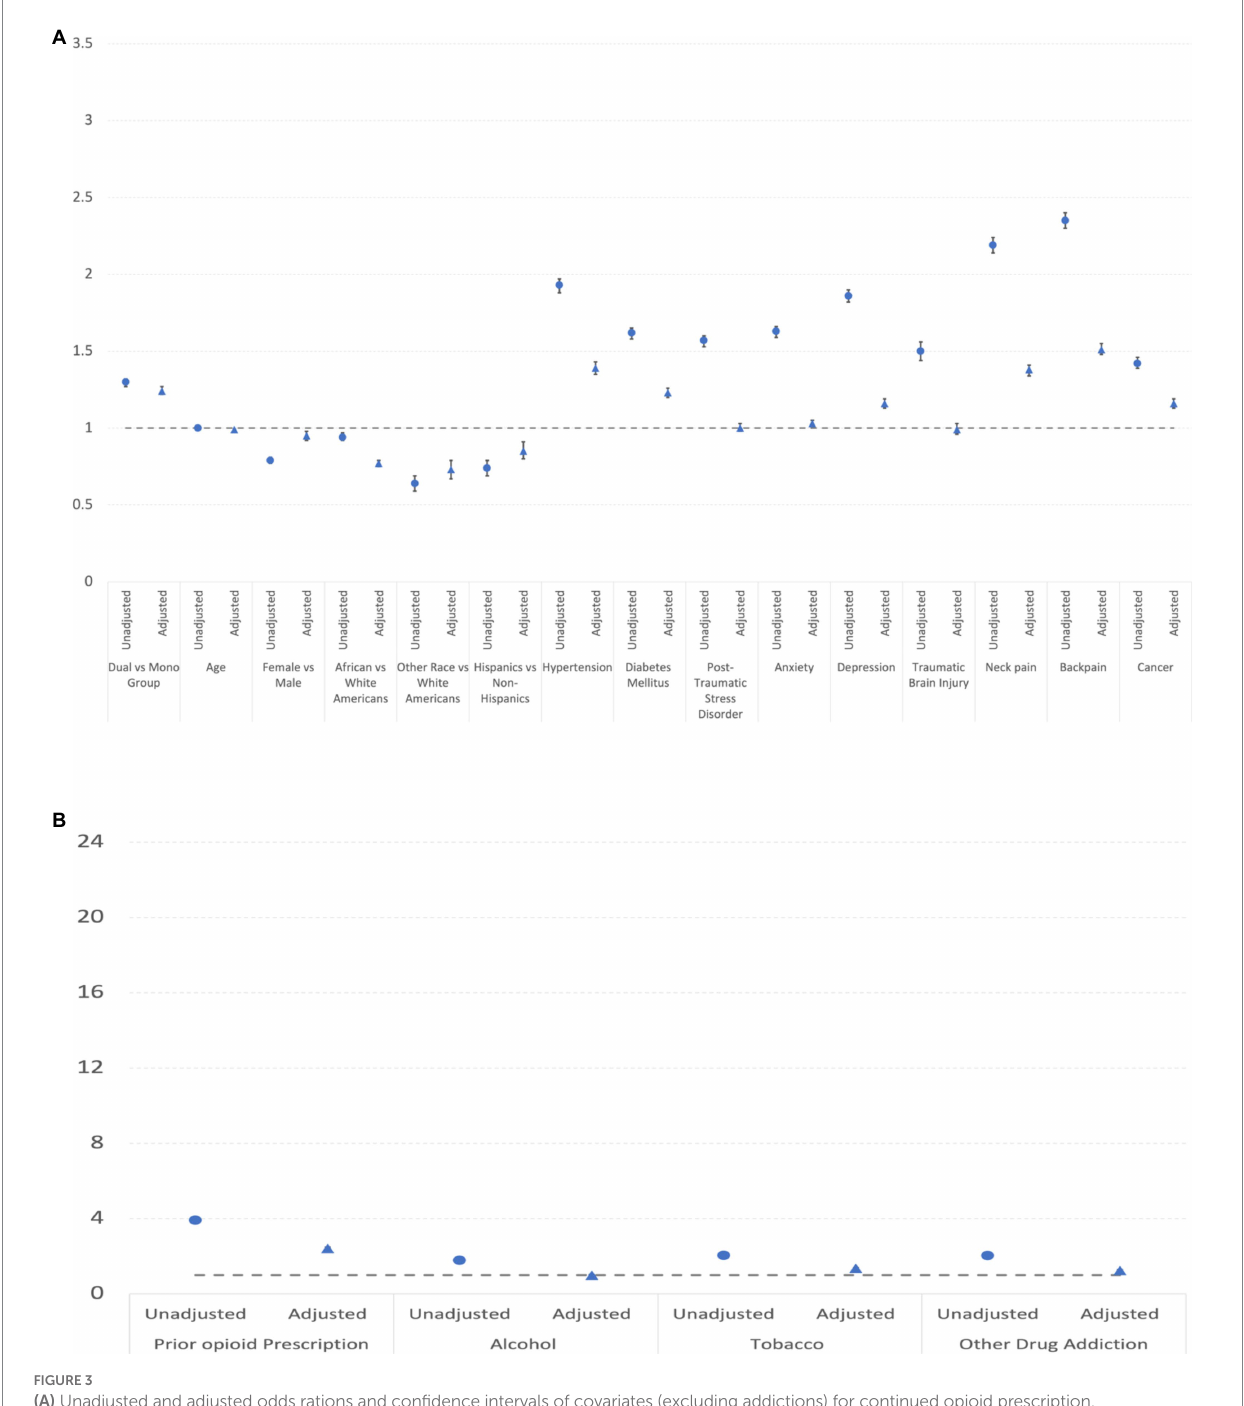
FIGURE 3 (A) Unadjusted and adjusted odds rations and confidence intervals of covariates (excluding addictions) for continued opioid prescription. (B) Unadjusted and adjusted odds rations and confidence intervals of addiction covariates for continued opioid